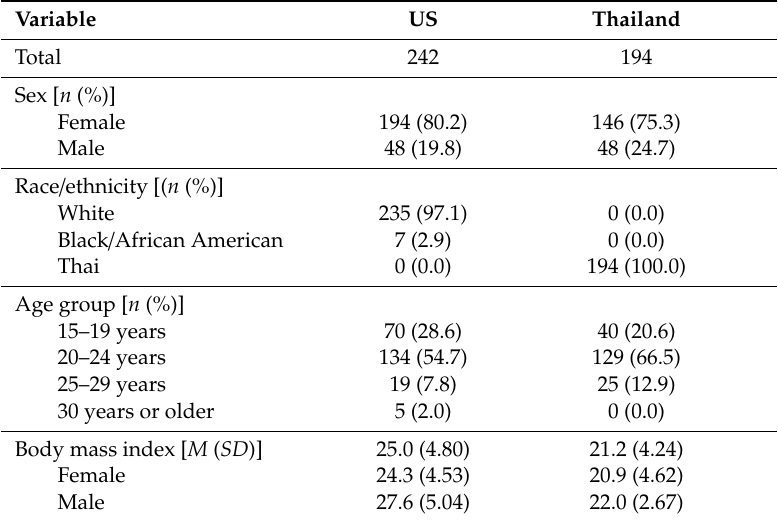
Table 1. Demographic characteristics of US and Thailand participants *.